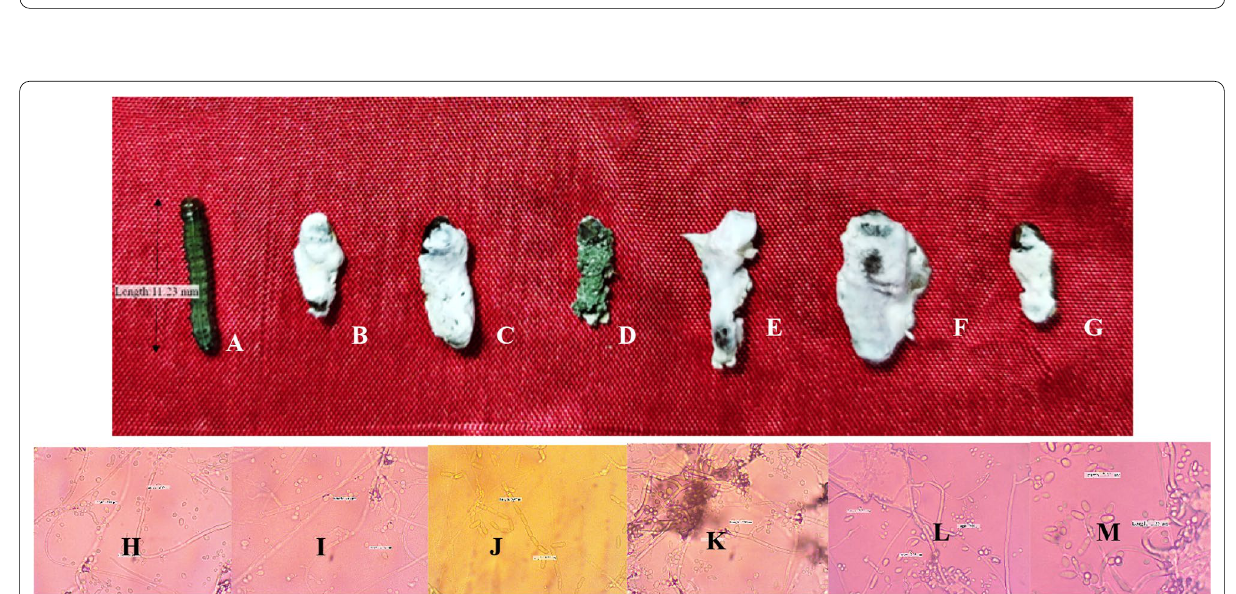
Fig. 3 Colony morphology of endophytic fungi from the leaves of maize where seed treatment was given and control (untreated seeds): Control ( A ), Beauveria bassiana of JGTP240521 isolate ( B ) and WTTJC260521A isolate ( C ), Metarhizium anisopliae WTTJC260521B isolate ( D ), Beauveria bassiana of WTTJC290521A isolate ( E ), WTTJC290521B isolate ( F ), and JGNT300521 isolate ( G )